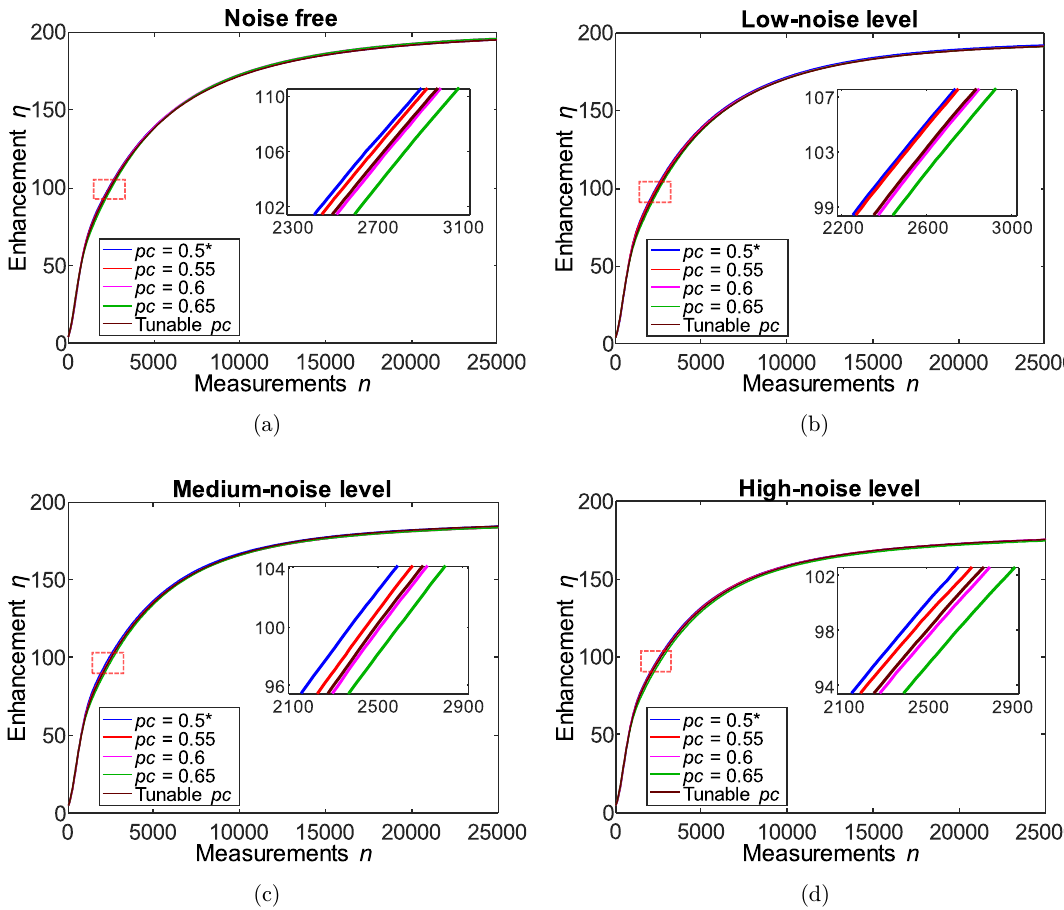
Fig. 5. Comparisons of di®erent choices of the parental mask ratio pc = 0.5 is the one used in Ref. 18, which is marked with an asterisk. (a) – (d) The enhancement as a function of the number of measurements under di®erent conditions: noise free, low-noise level, medium-noise level, and high-noise level. Insets are provided for visualization